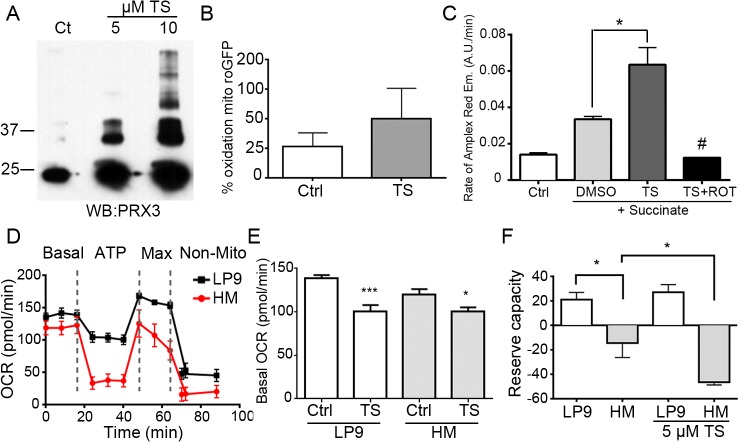
Thiostrepton modifies PRX3, increases mitochondrial H2O2 and disrupts mitochondrial bioenergetics in MM cells.(A) Recombinant PRX3 (rPRX3) was incubated with indicated concentration of thiostrepton (TS) for 30 min and visualized by immunoblotting with anti-PRX3 antibody after separation by reducing SDS-PAGE. (B) Mitochondrial redox status was analyzed by ratiometric live cell imaging of mito-roGFP in HM cells treated with 5 μM TS for 6 hr (n = 10 cells). (C) Hydrogen peroxide production in isolated mitochondria respiring on succinate (+ succinate) in the presence of indicated compounds (TS = thiostrepton, ROT = rotenone) (* p < 0.05, # p < 0.05 compared to TS). (D) Bioenergetic profiles (oxygen consumption rate, OCR) for LP9 and HM cells (n = 5). Dotted lines indicate time points of drug injections (oligomycin, CCCP, rotenone/antimycin A, respectively) (E) Basal OCR of LP9 and HM cells treated with 5 μM TS for 6 hr (n = 5, * p < 0.05, *** p < 0.001, Error bars represent SEM). (F) Reserve capacity of LP9 and HM cells untreated or treated with 5 μM TS for 6 hr (n = 5, * p < 0.05, Error bars represent SEM). See also S2 Fig.